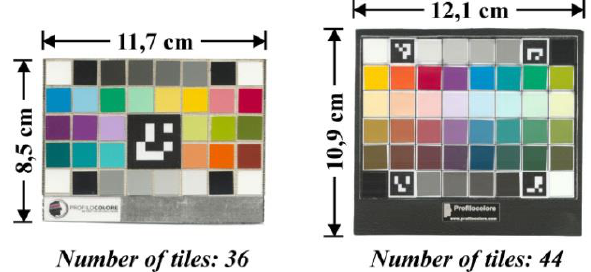
Figure 4. Colourimetric targets by Profilocolore Srl: left, Mark.06; right,